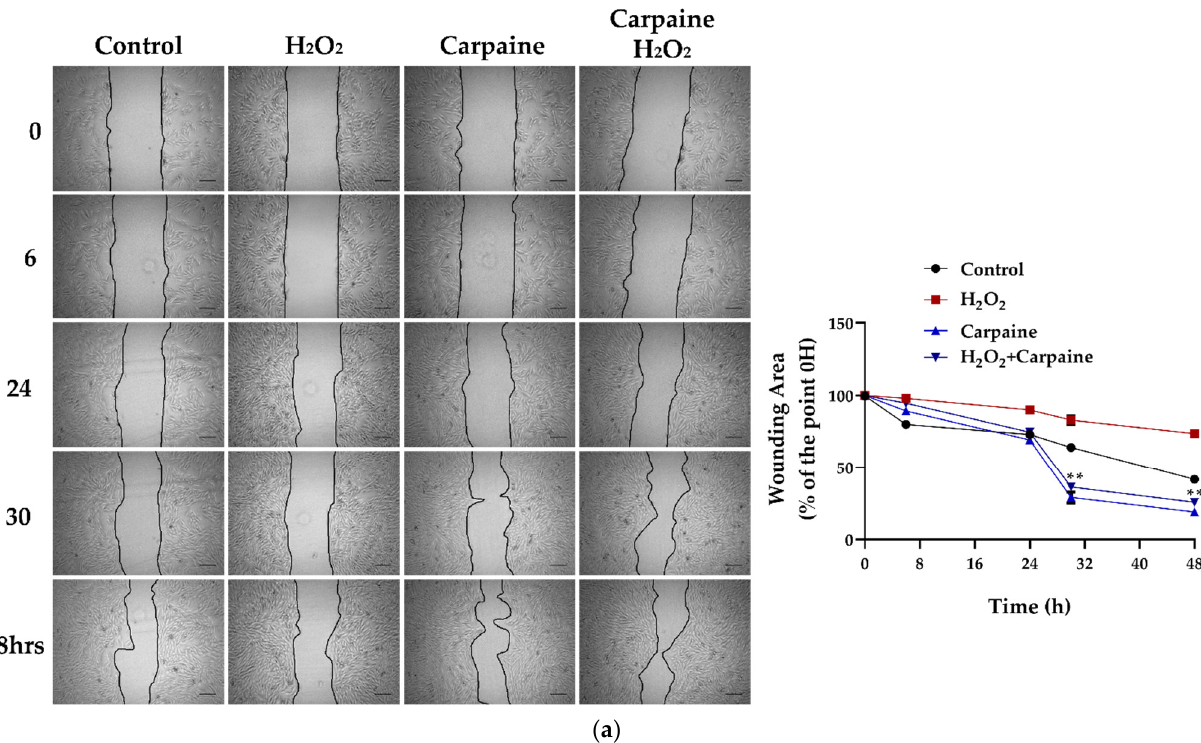
5 of 14 Figure 2. Carpaine triggers upstream FAK-induced ERK1/2 and AKT activation in H9c2 cells. ( a ) Carpaine treatment induces FAK, AKT, and ERK1/2 phosphorylation in H9c2 cells in a time-de- pendent manner. H9c2 treated with or without carpaine (1 µM) for 0, 5, 15, and 30 min. Representa- tive Western blot images and the quantification of phosphorylated FAK (pFAK), phosphorylated AKT (pAKT), and phosphorylated ERK (pERK) levels, normalized to total FAK (tFAK), total AKT (tAKT), and total ERK (tERK), respectively. The protein band intensity is expressed as the fold change compared to the 0 min group. ( b ) Carpaine treatment mediates H9c2 proliferation via